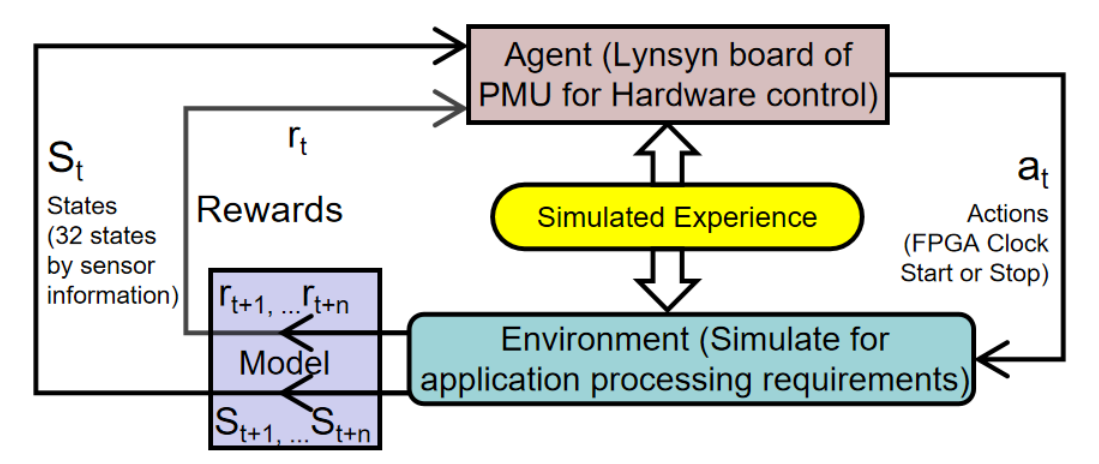
Figure 2. System setup for power measurement utility for reinforcement learning (PMU-RL) algorithm workflow.